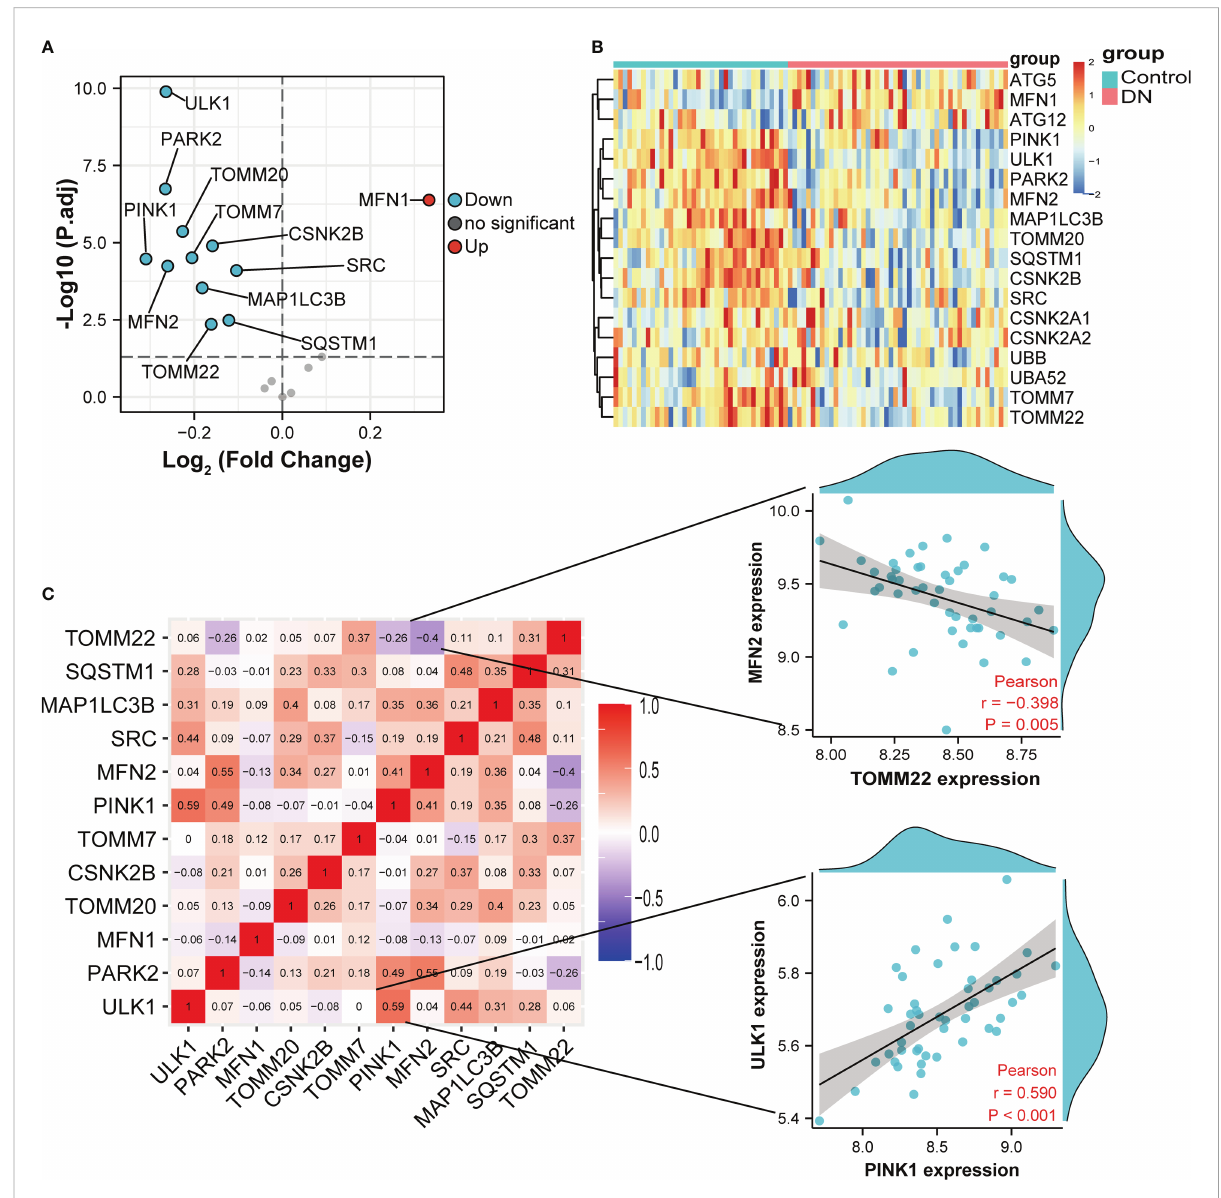
FIGURE 3 Variance analysis of mitophagy-related genes in DN. (A) Volcano plot showing a summary of the expression differences of 18 mitophagy-related genes between the healthy and DN patients ’ glomerular samples. (B) The clustering heatmap exhibited the expression pattern of DE-MRGs among glomeruli samples. (C) Correlations between DE-MRGs in DN glomeruli samples and the respective scatterplots show the two pairs of MRGs with the highest correlation. Correlation analysis was assessed using Pearson